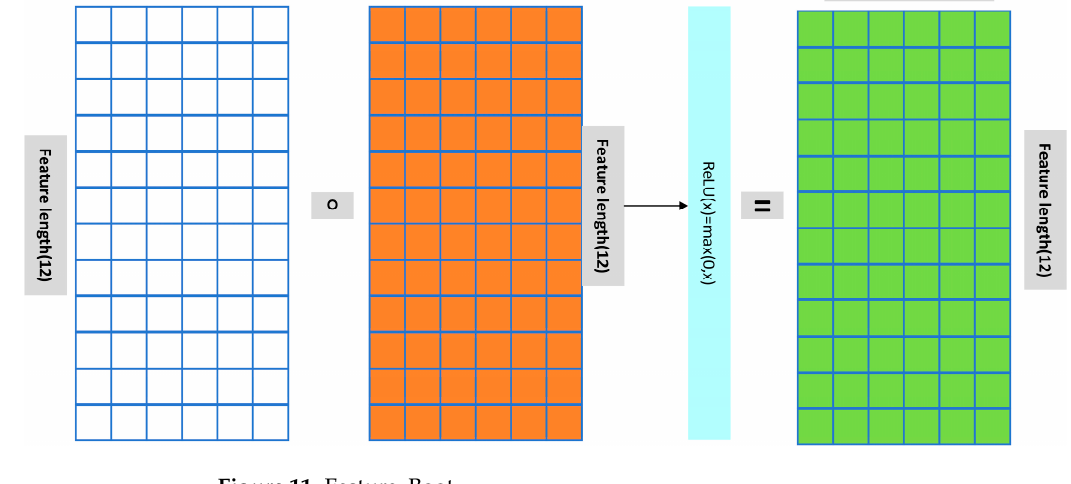
Figure 11. Festure_Boot.